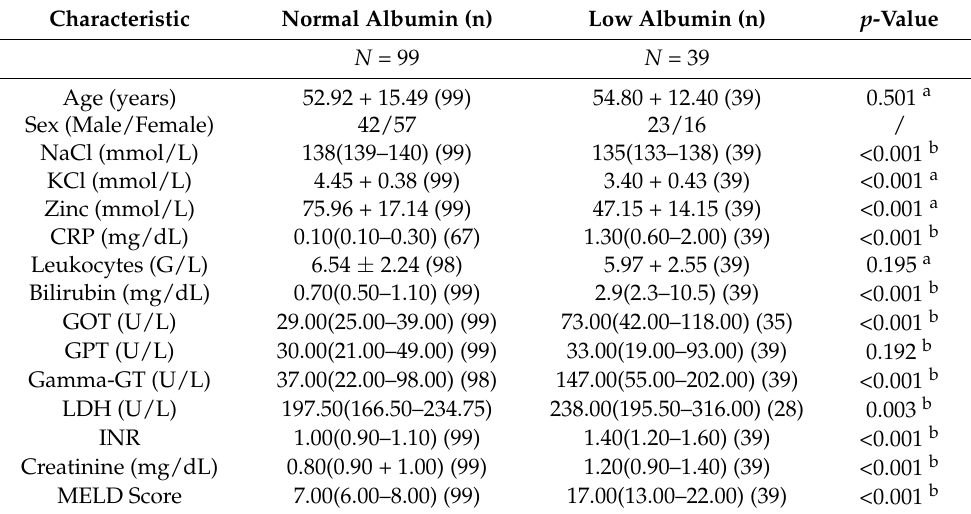
Table 2. Characteristic analysis based on different albumin concentrations.